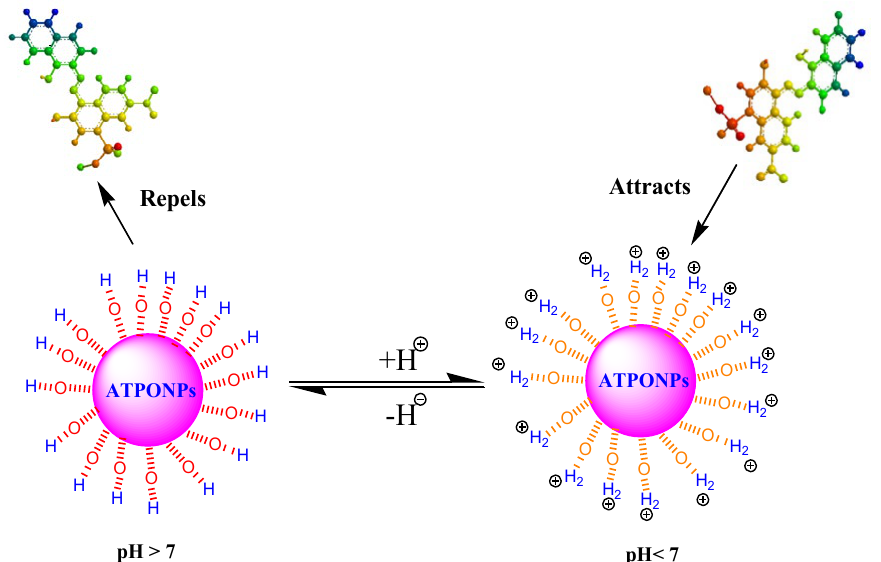
Fig. 7: Schematic representation of electrostatic interaction between protonated (ATPO-NPs) adsorbent surface and EBT dye.